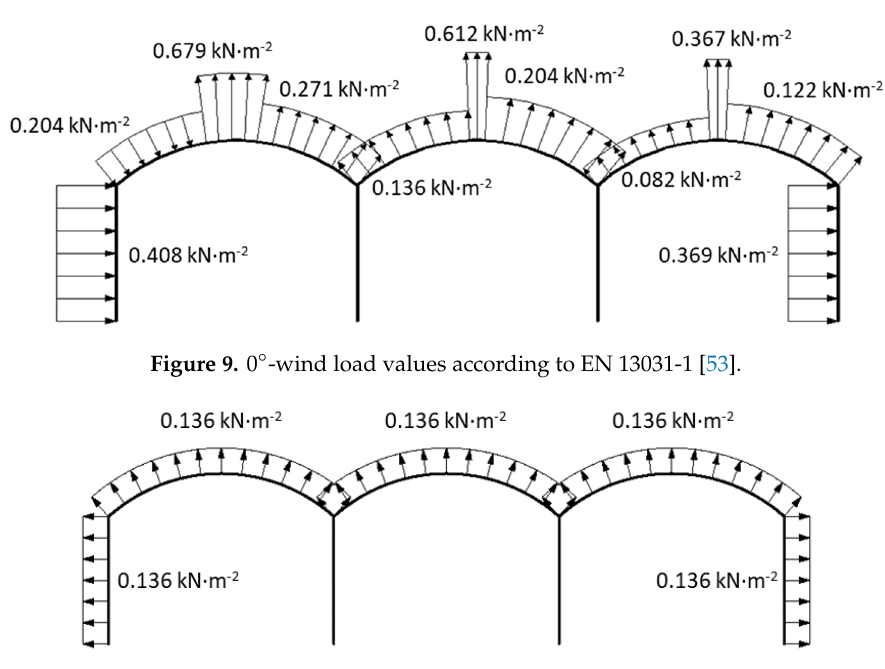
Figure 10. 90 ◦ -wind load values according to EN 13031-1 [53]. Figure 10. 90°-wind load values according to EN 13031-1 [53].